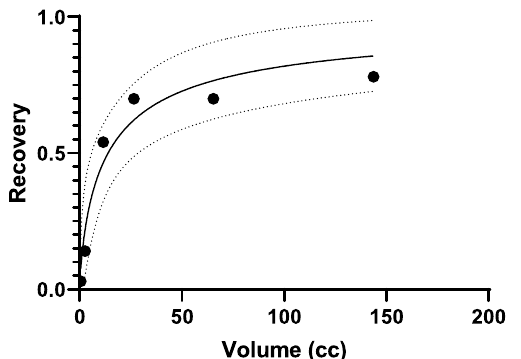
Fig. 2 Recovery curve with 95% confidence intervals (dashed line) determined by an empirical fit to the spherical insert